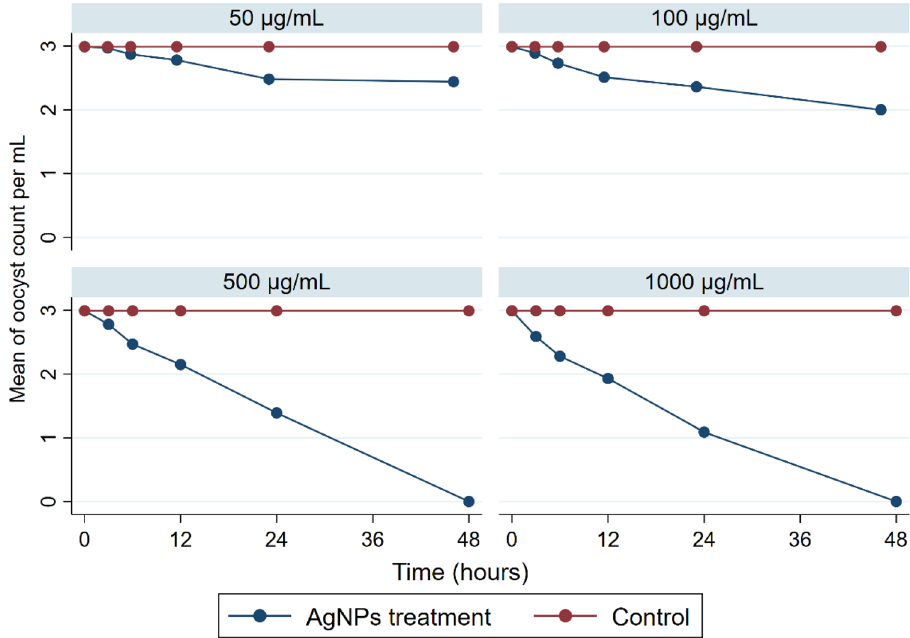
Figure 3. Time kill curve of C. parvum treated with AgNPs at different concentrations.